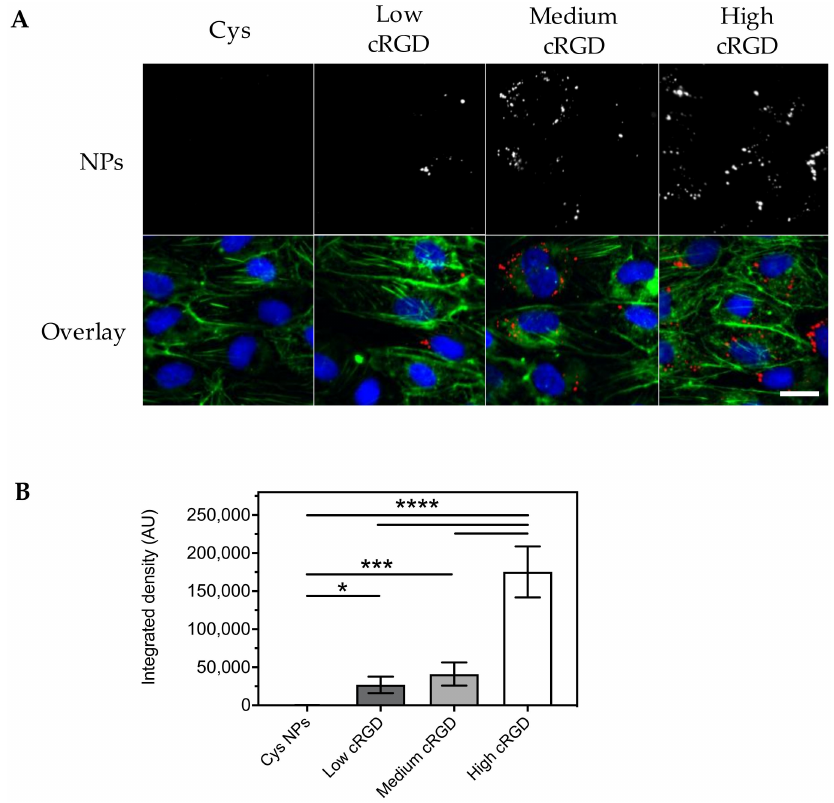
Figure 4. Association of Cys-NPs and cRGD-NPs of di ff erent ligand densities to HUVECs after 16 h incubation under flow (shear rate 300 s − 1 ) in EBM-2 medium at 37 ◦ C. ( A ) Representative images obtained with an epifluorescence microscope (cropped images). Nuclei are stained in blue, cytoskeleton (F-actin) is stained in green and NPs are observed in red. The same brightness and contrast settings were used for the red channel in all images. ( B ) Image analysis: fluorescent signal for the NPs is reported as integrated density (n = 10). All images obtained from the di ff erent formulations were processed in the same manner (background subtraction and equal thresholding). Data (mean ± SD) were analyzed by one-way ANOVA followed by Tukey’s multiple comparison test; * p -value < 0.05, *** p -value < 0.001 and **** p -value < 0.0001. Scale bar represents 20 µ m.